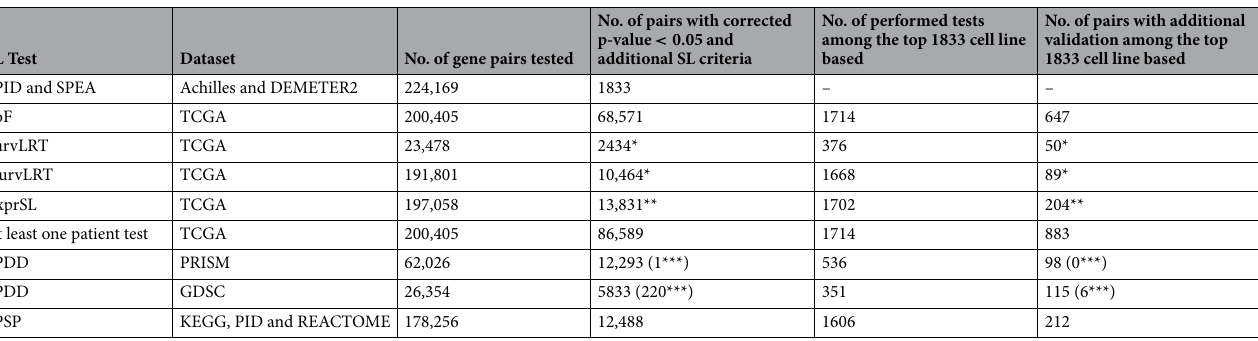
Table 1. Summary of the performed SL tests. The number of gene pairs tested using each test differs because the tests have different application criteria and are performed on different datasets. Additional test criteria for gene pairs: *SL flag and CL flag in SurvLRT and iSurvLRT tests equal to 1; **absolute correlation for ExprSL test higher than 0.4; ***using the adjusted